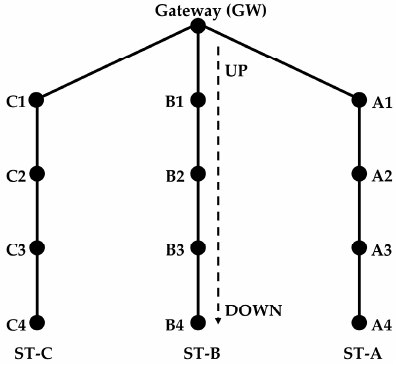
Figure 2. Network Topology of N Strings.